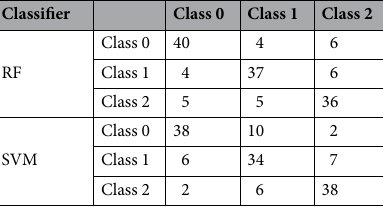
Table 6. Classification results, expressed as a confusion matrix, for the three-groups comparison with the two tested classifiers, using only the LF Power (%) and MSE17 features.